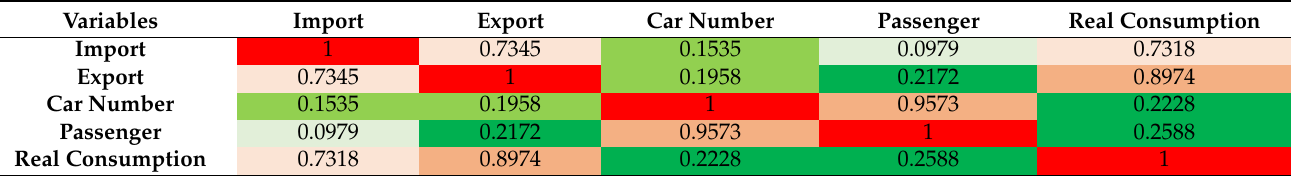
Table 5. Gokceada correlation matrix between dependent and independent variables.